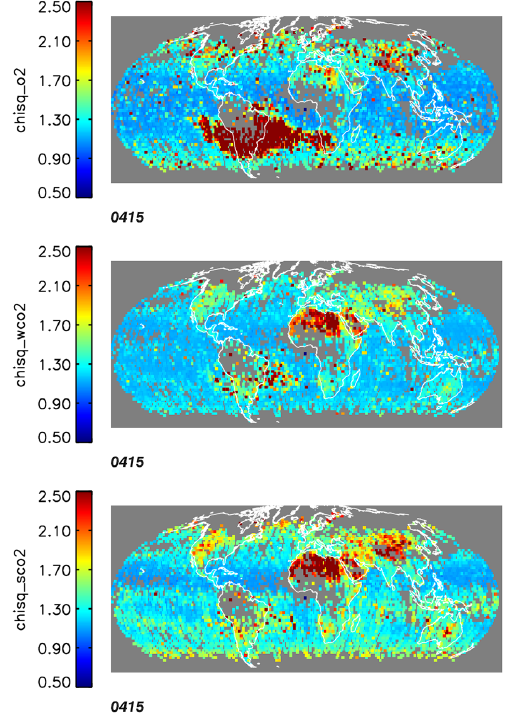
Figure 7. Maps of the fitting parameter χ 2 three bands of the OCO- 2 instrument in April 2015. Statistics are provided for 2 ◦ by 2 ◦ bins for data selected with the data quality flag.